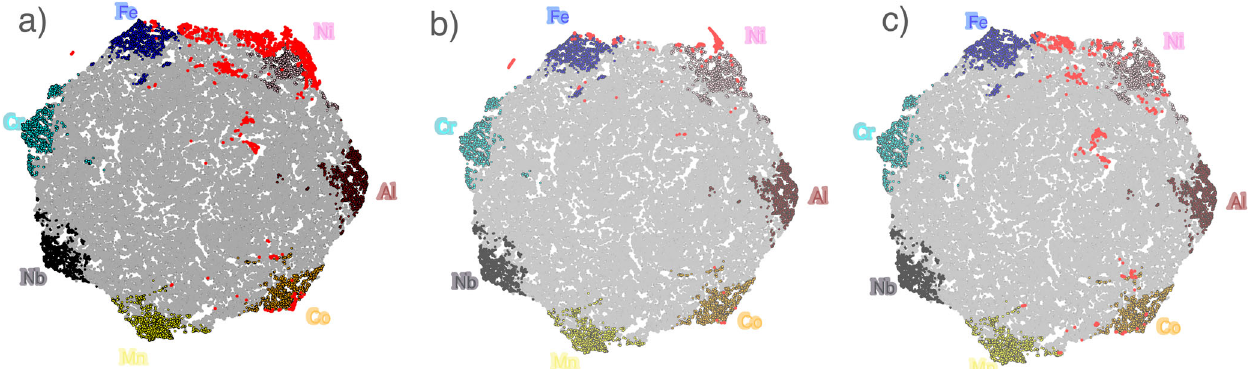
Fig. 9 Exhaustive search vs PSO results. tSNE representation of FCC selected/optimized data-points (in red) obtained through a PSO analysis in top of a subset of 100,000 randomly selected compositions for reference on the seven-component system: Al-Co-Cr-Fe-Mn-Nb-Ni. a fi ltering for FCC phase fraction greater than 0.97 from a random sampling. b PSO optimized full phase fraction FCC, c PSO optimized phase fraction FCC and entropy maximization.).